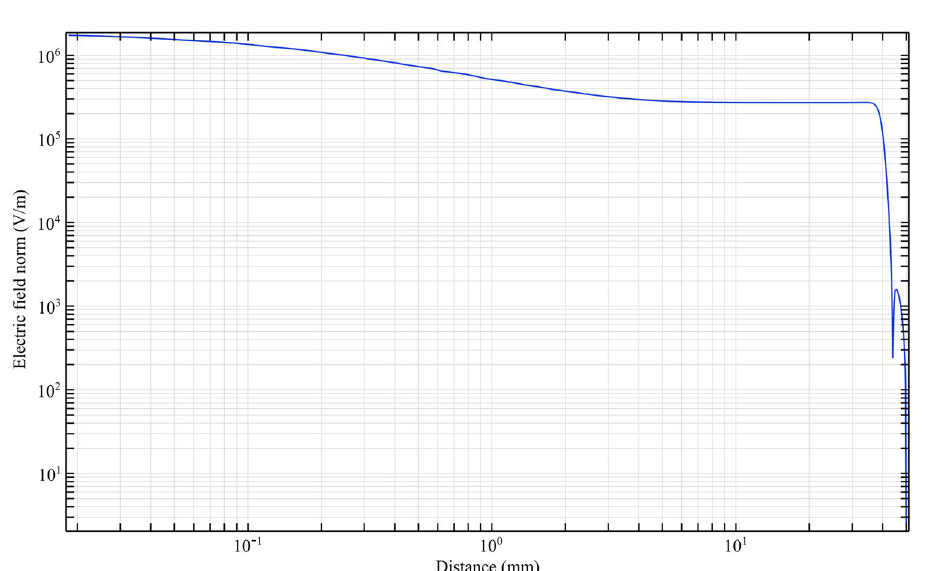
Figure 11. Simulation of electric field from tip electrode to end of plasma jet nozzle based on nozzle Fig.